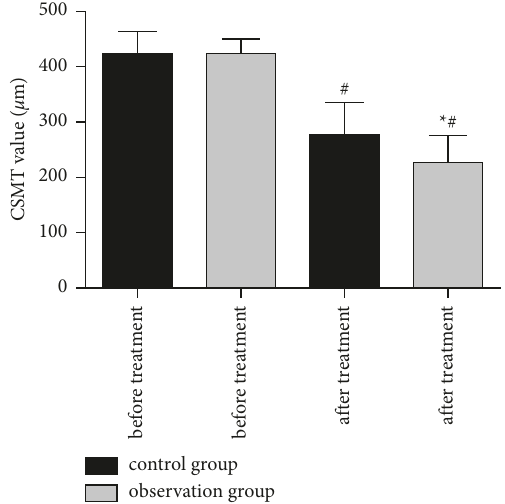
Figure 3: CSMTvalues of two groups of patients at different times. Compared with the same group before treatment, # P < 0 . 05; compared with the control group, ∗ P < 0 . 05.